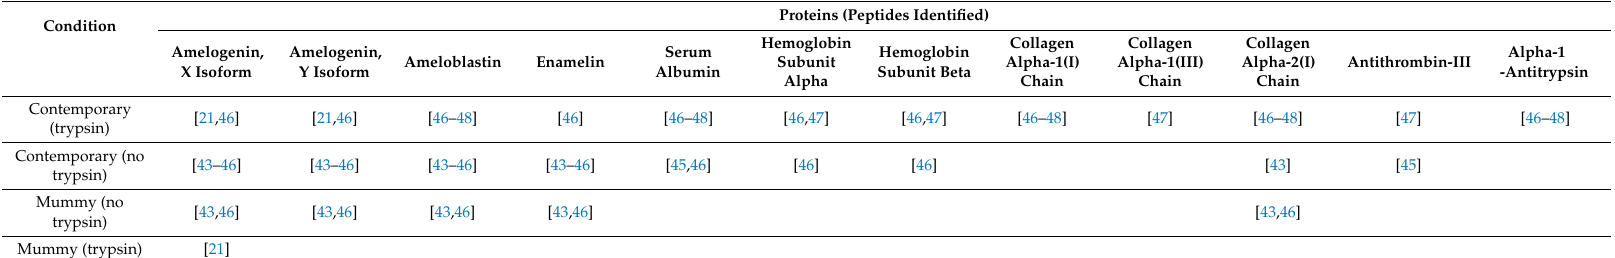
Table 2. Proteins identified from contemporary and archeological enamel